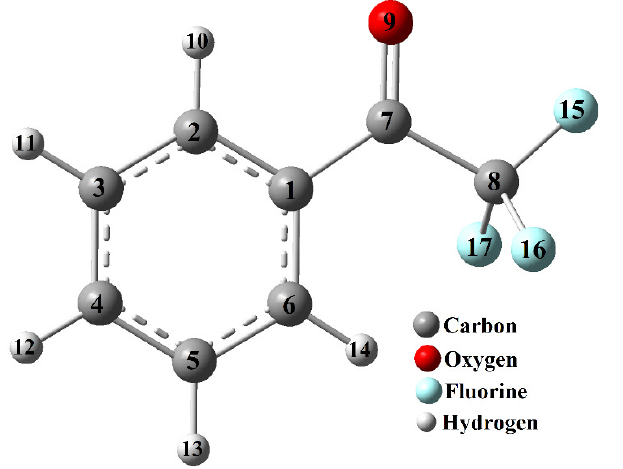
Figure 1. Optimized structure and atom numbering of TFAP